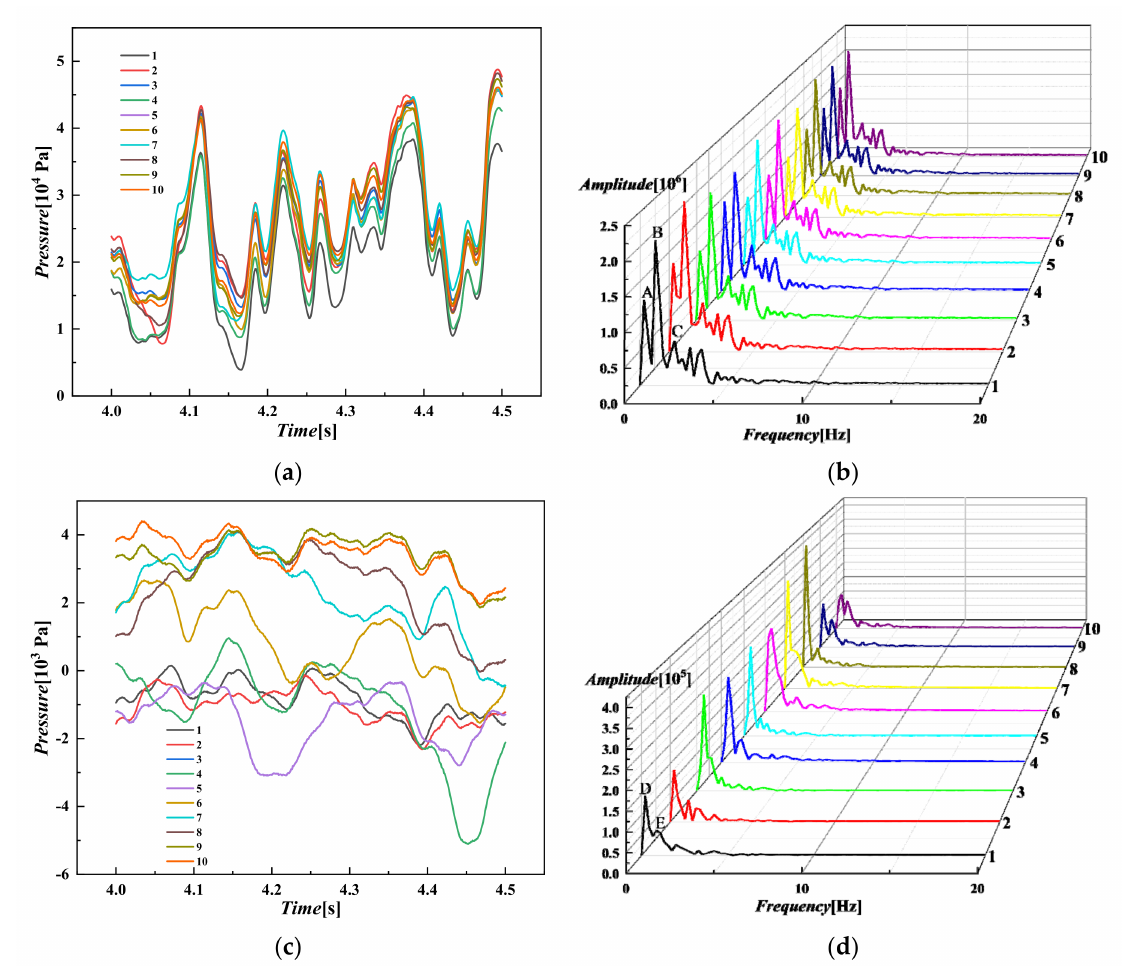
Figure 17. Time domain diagram and frequency domain diagram of pressure fluctuation. ( a ) time domain diagram (optimal condition); ( b ) frequency domain diagram (optimal condition); ( c ) time domain diagram (small opening condition); ( d ) frequency domain diagram (small opening